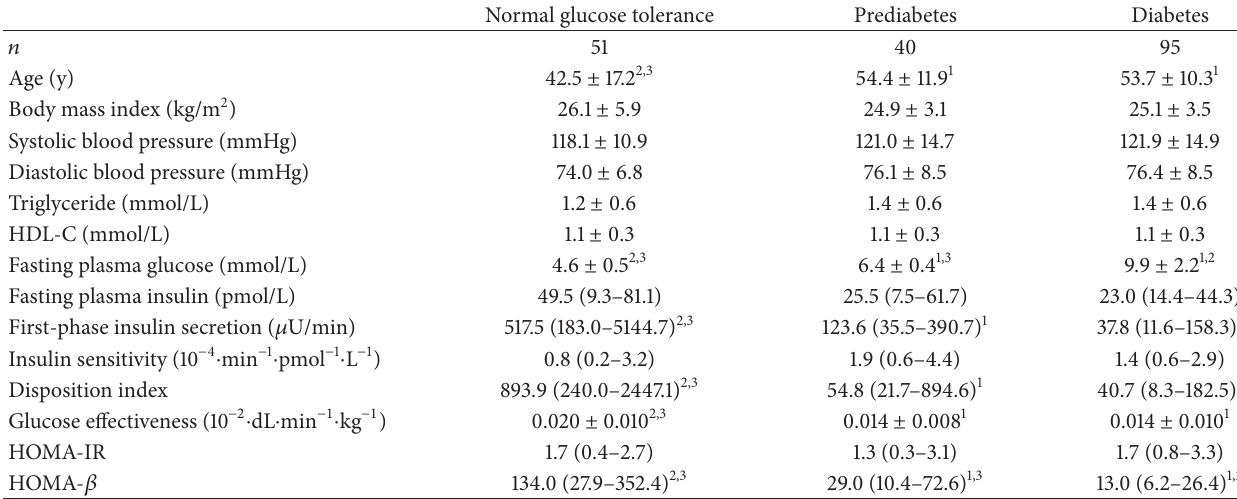
Table 2: Demographic data of normal glucose tolerance, prediabetes, and diabetes